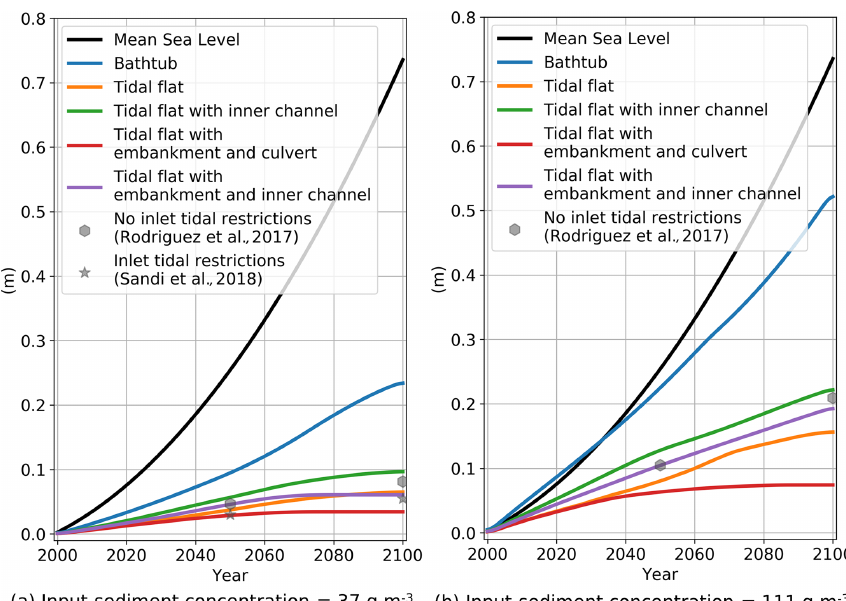
Figure 4. Sea-level rise and domain-average accumulated accretion over time for all simulations for (a) low sediment input and (b) high sediment input. Results from Rodriguez et al. (2017) and Sandi et al. (2018) corresponding to the entire Area E wetland are included for